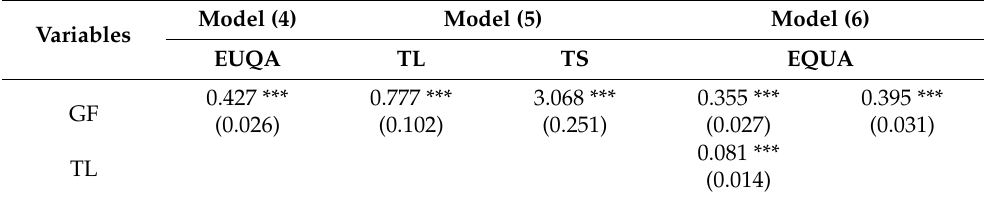
Table 7. Regression results of the mediated effects model with